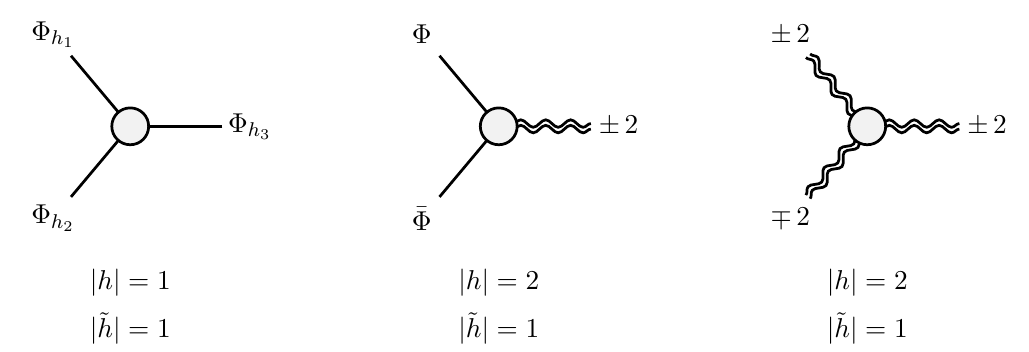
Figure 1 . Three-point amplitudes in a marginal theory minimally coupled to gravity. Amplitudes exclusively among the matter particles Φ , which can be scalars φ , fermions ψ or vectors V , carry total helicity h = ± 1 . Gravitational amplitudes in contrast have helicity h = ± 2 , the sign being determined by the graviton helicities only. Characterized in terms of a modified helicity ˜ h = h − 1 all 3-point amplitudes are on the same